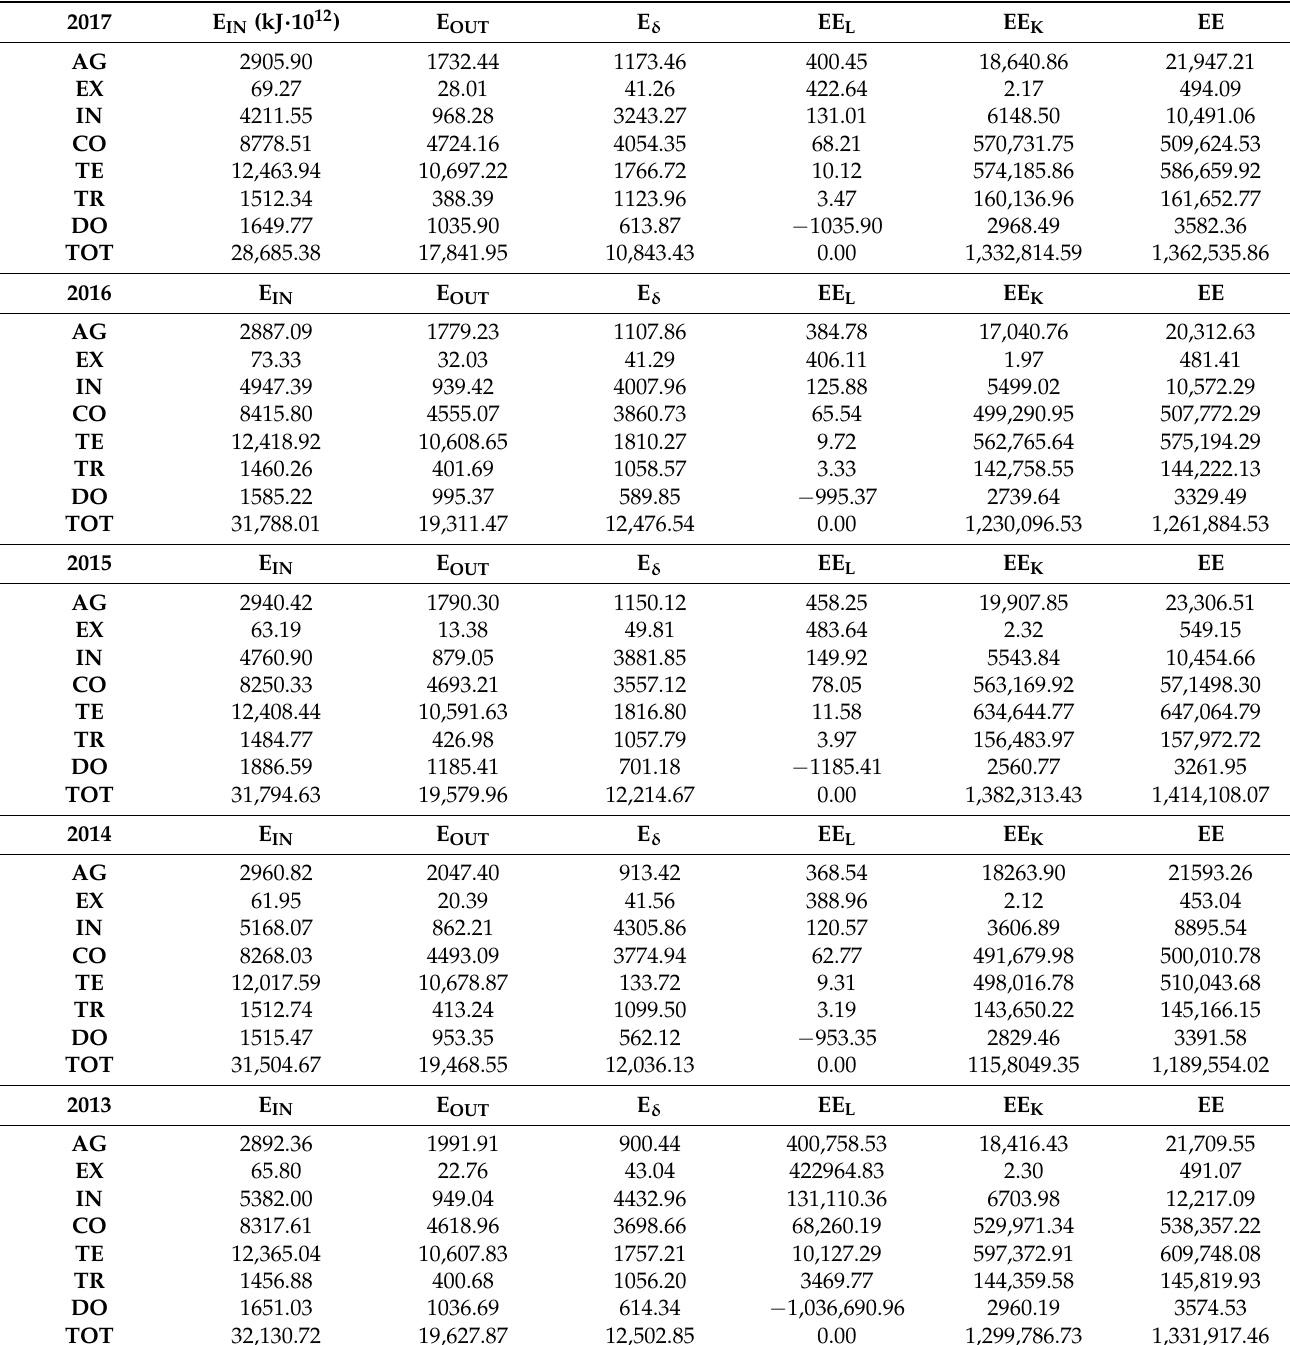
Table 2. Results of the EE Analysis for Italy, 2013–2017. All data are shown in kJ · 10 12